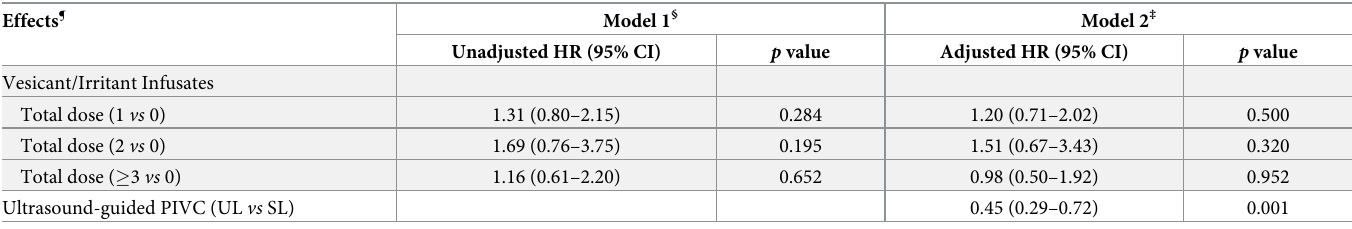
Table 4. Effects of total dose of vesicant/irritant infusates on intravenous line failure.